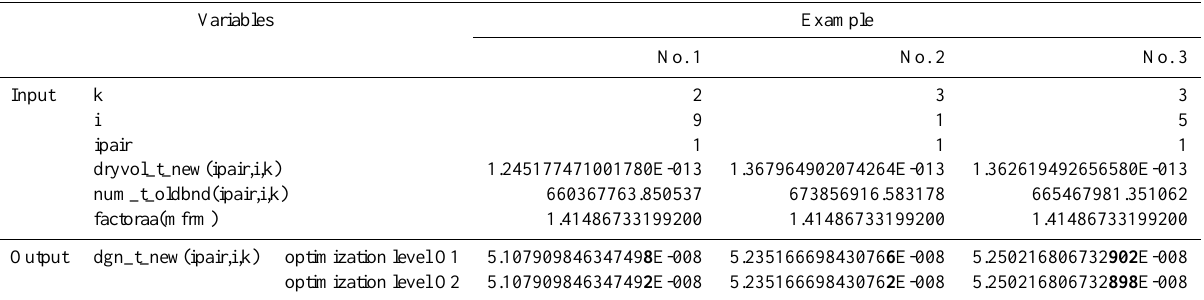
Table 15. Examples of different results of the calculation at line 330 of Fig. 2 when changing the compiler optimization level from O1 to O2 . The input of the calculation is the same (bitwise identical) at both compiler optimization levels. The different digits in the results are highlighted in bold.